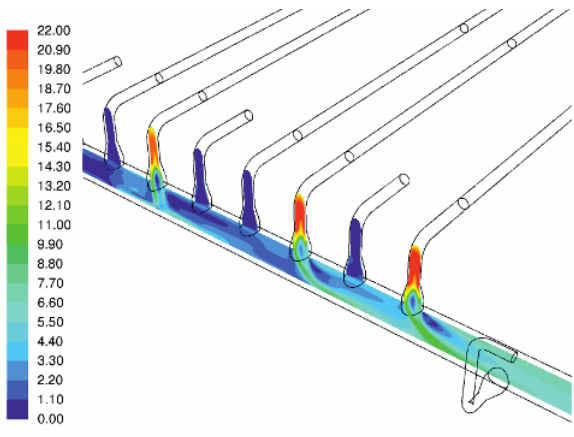
Figure 13: Average velocity in exit pipe